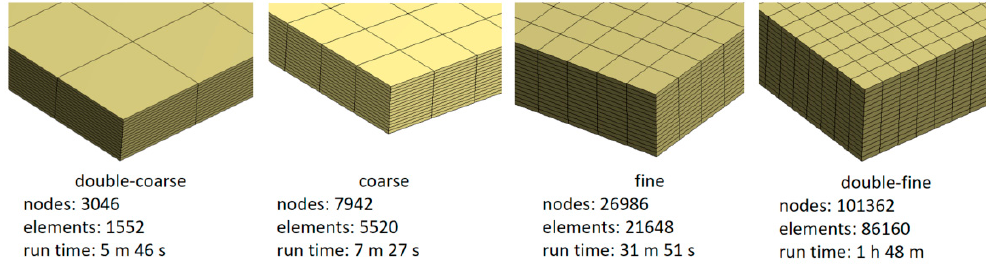
Figure 7. Mesh sensitivity analysis: mesh sizes. Materials 2019 , 12 , x FOR PEER REVIEW Figure 7 . Mesh sensitivity analysis: mesh sizes .